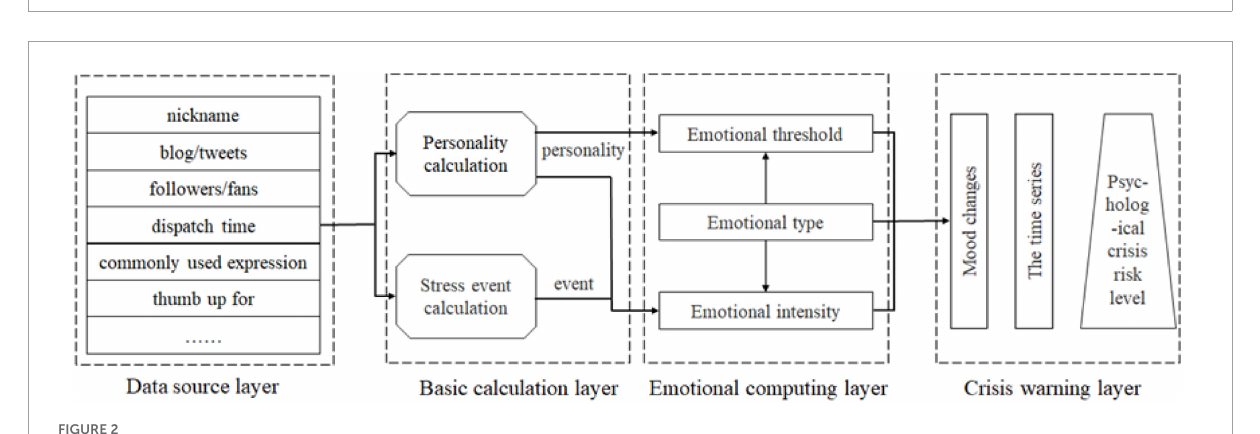
FIGURE2 Psychological crisis warning model based on social media big